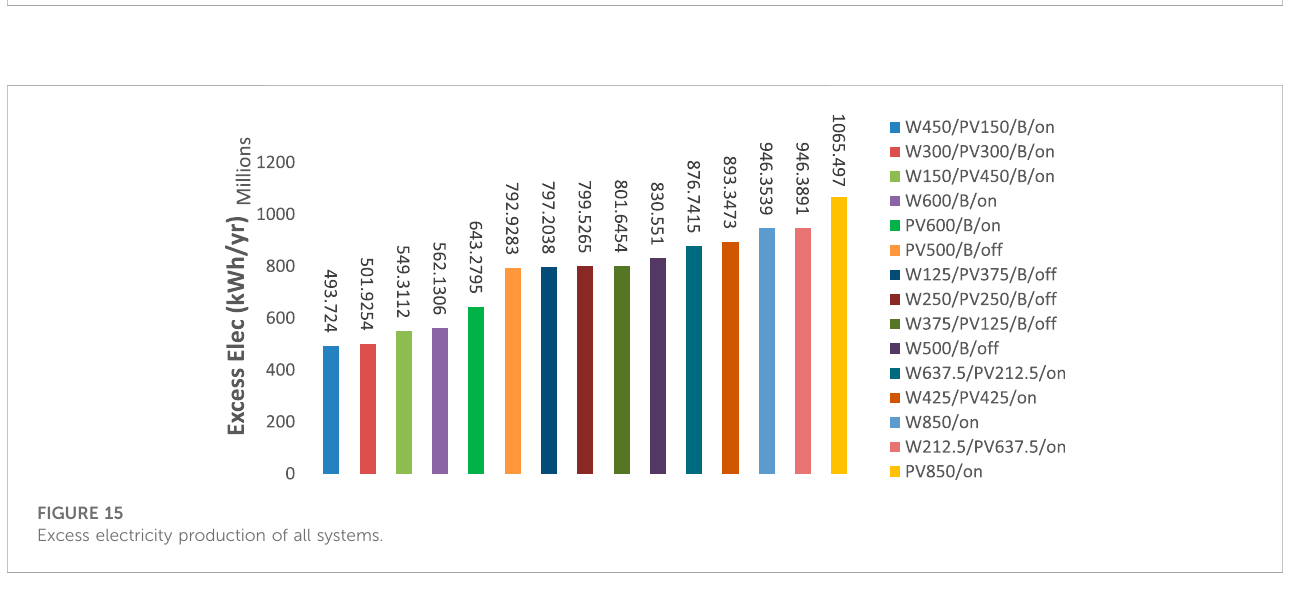
FIGURE 14 Electricity production of all systems.